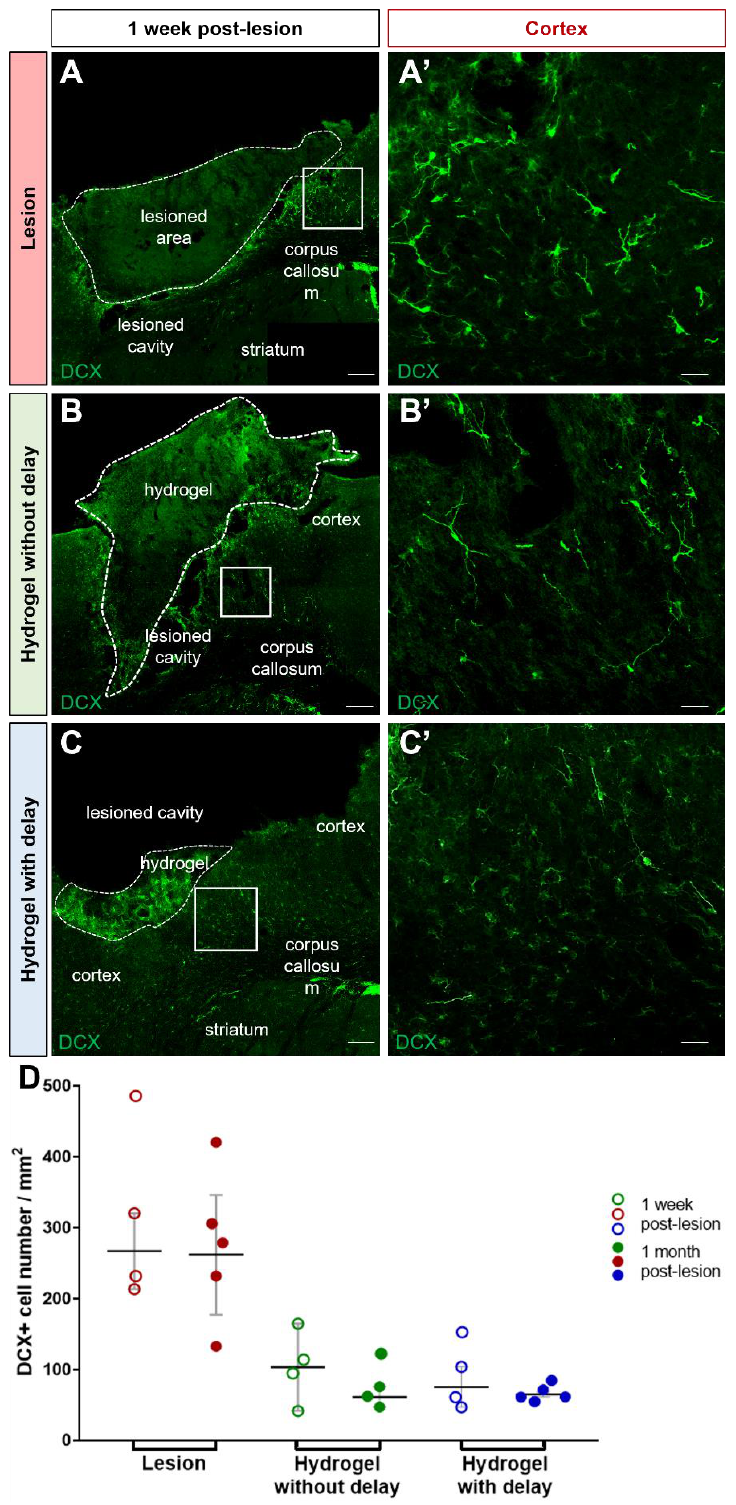
Figure 4. Neuroblasts migration to the cortex. ( A – C ) Representative immunofluorescence staining of neuroblasts labeled with DCX (green) in lesioned ( A ) or no-delay implanted ( B ) or delay implanted groups ( C ). Dashed lines indicate hydrogel localization. The squares indicate the area of magnification. Scale bar: 200 μm. ( A ′ – C ′ ) High magnification images of the neuroblast in the cortex. Scale bar: 20 μm. ( D ) Quantitative analysis of the number of the neuroblast over time in lesioned (red) or implanted mice without delay (green) or with delay (blue). Two-way ANOVA.